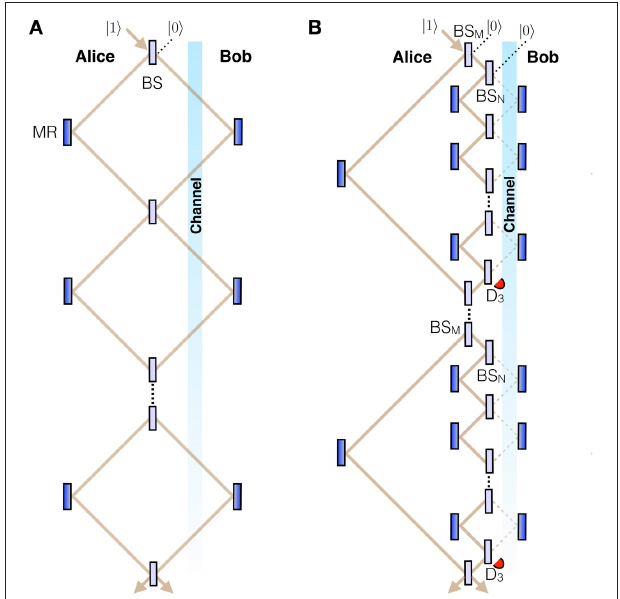
FIGURE 1 | Proposal for counterfactual Mach-Zehnder CNOT. Bob effects a quantum superposition of blocking and not blocking the channel, not practical for this Mach-Zehnder scenario, which acts as the CNOT’s control qubit. (A) , Partially counterfactual CNOT gate. Beamsplitters BS are cos 2 π/ 2 N , where N is the total number highly reflective, with reflectivity R = of BS s. The gate, however, only works for one of Alice’s inputs (“0”). Moreover, it is not counterfactual for the part of the superposition where Bob does not block, in which case the photon passes through the channel. (B) , Fully counterfactual CNOT gate based on the chained quantum Zeno effect (CQZE). Between successive BS M s, of which there are M , there are N beamsplitters BS N . While the scheme only works for Alice’s “0” input, complete counterfactuality is ensured as any photon going into the channel would be lost due to measurement by Bob’s object or else end up at one of the detectors D 3 : the chained quantum Zeno effect. For large enough M and N , the probability amplitude of the photon being in the channel is virtually zero.